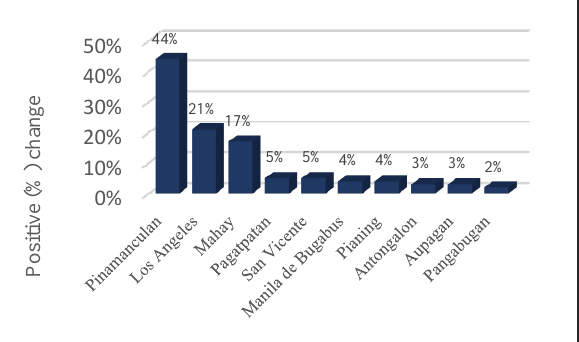
Figure 18. Top 10 barangays with increasing carbon footprint